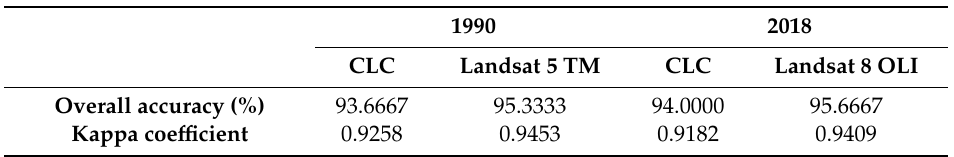
Table 3. Main accuracies of built-up land cover mapping from CLC 1990 / 2018 and thematic classification of Landsat TM (1990) / Landsat OLI